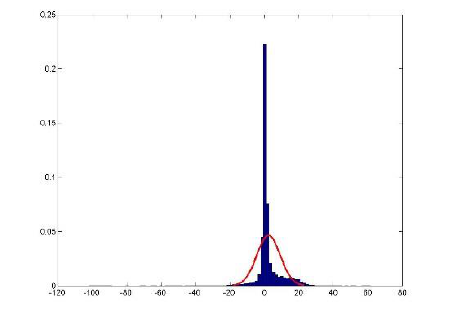
Figure 12: Histogram of the Height differences